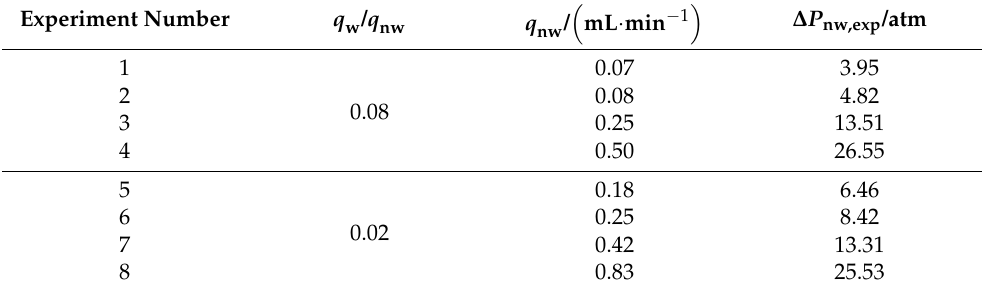
Table 7. Experimental data of core affected by capillary end effect under different flow rates.